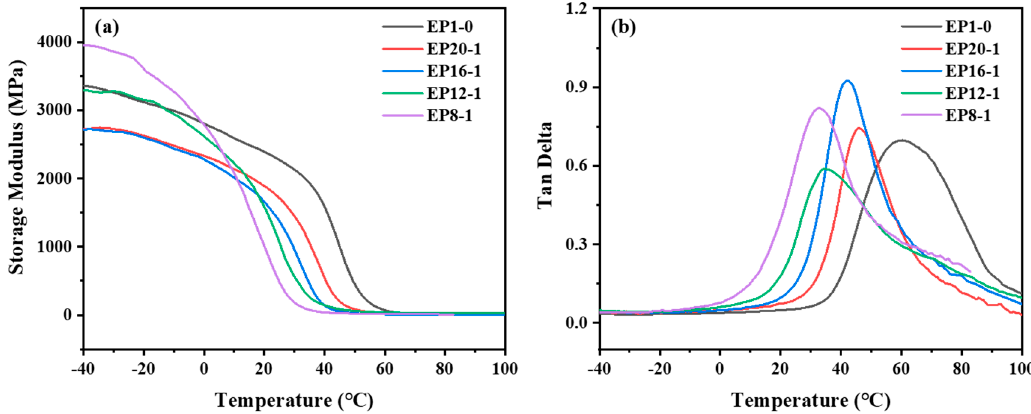
Figure 9. The storage modulus curves ( a ) and the loss factor curves ( b ) of EPx